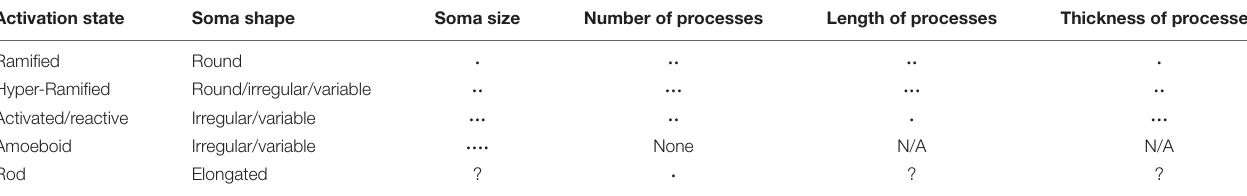
TABLE 2 | Microglial morphological parameters in various activation states. Activation state Soma size Length of